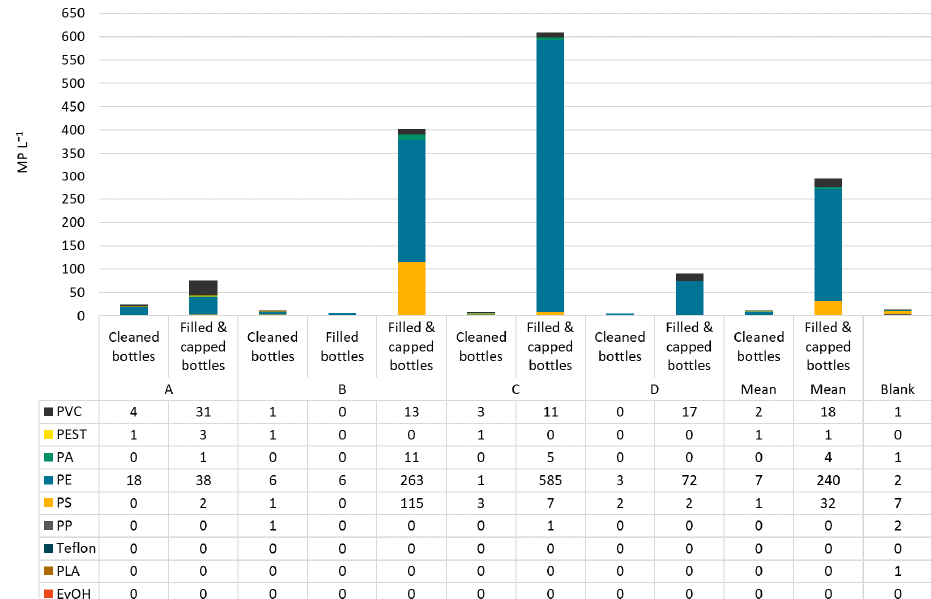
Figure 6. MP types and concentrations in cleaned, filled (B only) and filled and capped bottles from bottlers A–D.